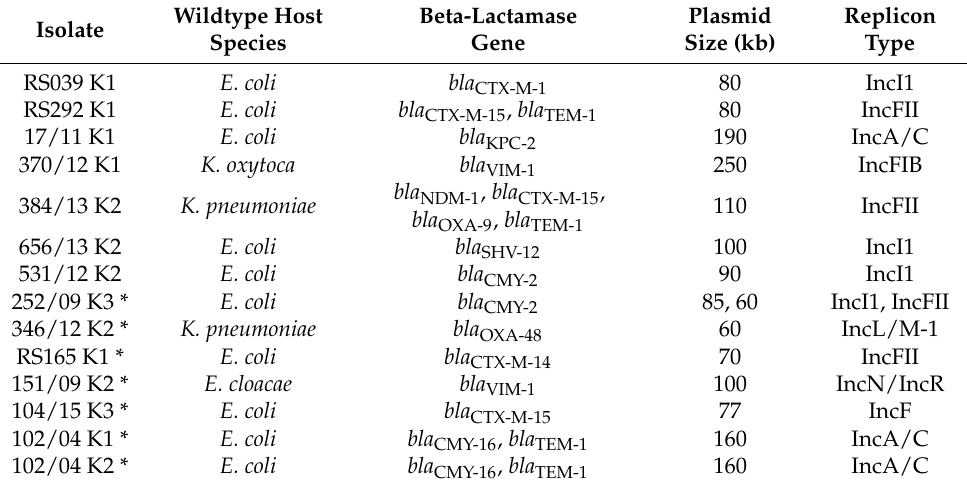
Table 1. Characteristics of the transconjugants (Kx) used for experiments on bacterial fitness.